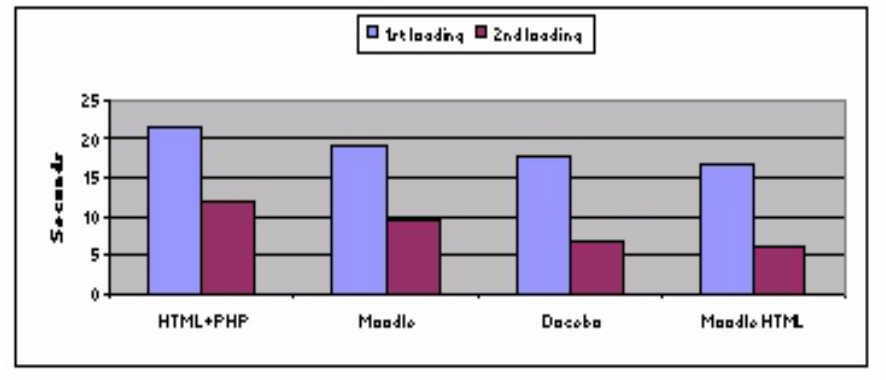
Figure 4. Browser loading speeds (Study B):